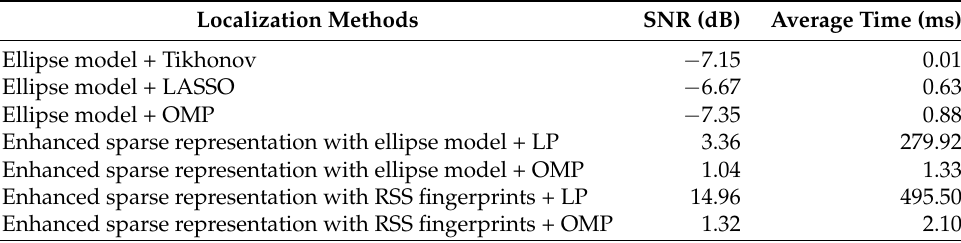
Table 3. Comparison of average SNR and time consumption in the indoor NLOS